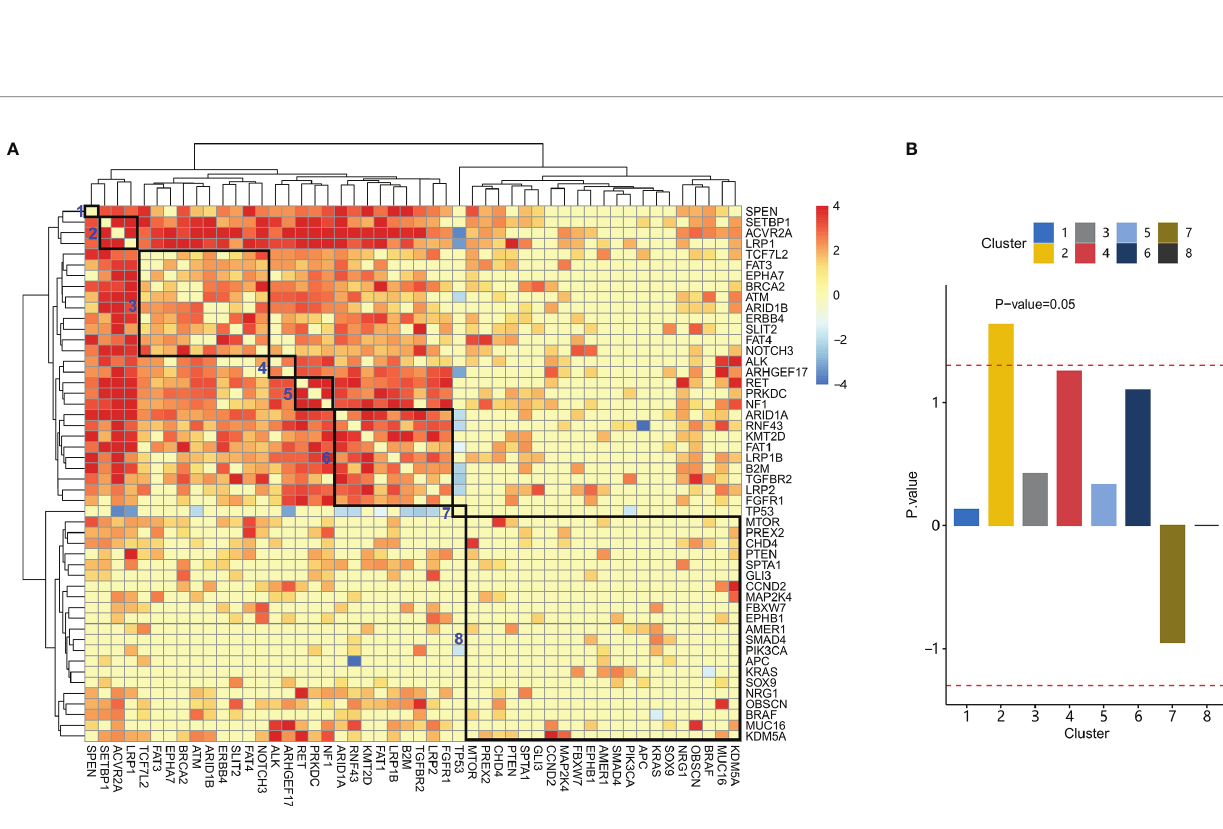
FIGURE 3 | Co-mutation between genes and their association with clinical characteristics. (A) Hierarchical clustering of the co-mutation score between genes. Eight gene clusters were enclosed with rectangles. From left to right, these clusters were labeled 1-8. (B) Association scores for each cluster were plotted. The dashed red line indicates an association score at P